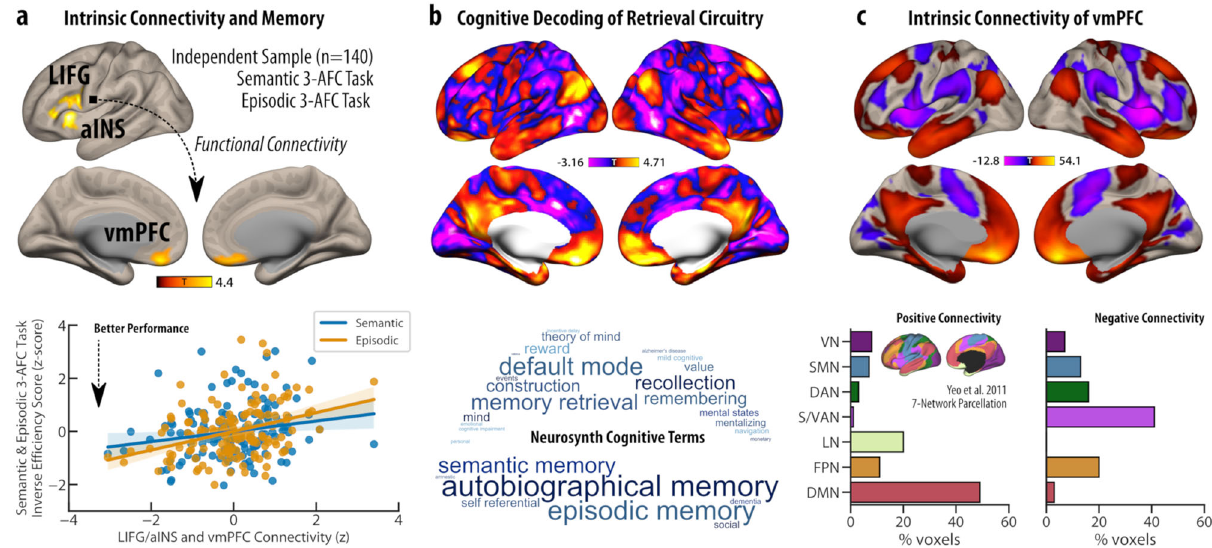
Fig. 4 Common neural circuitry linked to the controlled retrieval of semantic and episodic memory. a A large cohort of 140 participants underwent a nine-minute long resting-state fMRI scanning. In the analysis of this Experiment 2 dataset, the signi fi cant cluster that was linked to the retrieval of weak versus strong associations across both memory types in Experiment 1, was used as the seed region-of-interest in a functional connectivity analysis. Across participants, lower positive connectivity (greater anti-correlation) of the left inferior frontal gyrus/anterior insular cortex (LIFG/aINS) cluster to the bilateral ventromedial prefrontal cortex (vmPFC) was related to better performance in the retrieval of both weakly associated semantic and episodic word pairs, measured outside the scanner (corrected for age, gender and head-motion). The scatter plot is shown for illustrative purposes only. While the straight lines represent the best linear fi t over individual values, shaded areas illustrate 95% con fi dence intervals. Individual variation in this neural circuitry was not related to fl uid intelligence (partial r p = − 0.010, p = 0.45), or selective attention / inhibitory control (partial r p = 0.052, p = 0.27). n = 140 independent participants examined over one experiment. b The unthresholded results from this regression model were meta-analytically decoded for cognitive terms using the Neurosynth database. The top 100 terms are presented in a word cloud in which text size corresponds to the strength of association (anatomical terms were removed). c In a separate seed-based functional connectivity analysis, the positive connectivity ( r > 0) of the vmPFC revealed large overlaps with the default mode and limbic networks, whereas negative connectivity ( r < 0) was characterized by salience/ventral/dorsal attention and frontoparietal networks, based on the Yeo 7-Network parcellation scheme (VN = visual network, SMN = somatomotor network, DAN = dorsal attention network, S/VAN = salience/ventral attention network, LN = limbic network, FPN = frontoparietal network, DMN = default mode network). Source data are provided as a Source Data fi